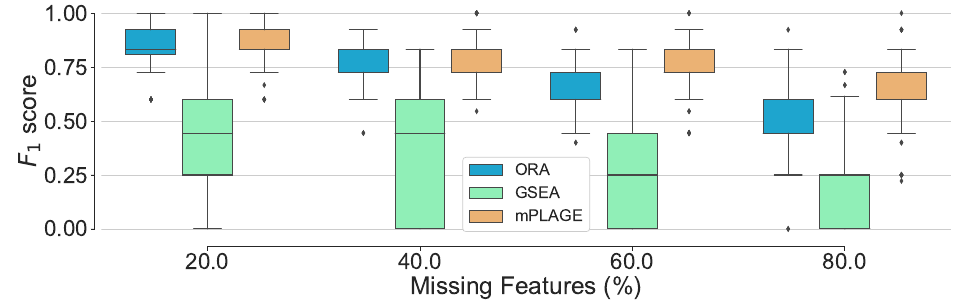
Figure 5. Overall performance of the different pathway ranking methods with missing features. Distribution of the F 1 scores for each method under an increasing proportion of missing features (20% to 80%) is shown. The results show that mPLAGE performs better, returning greater F 1 -scores at higher proportions of missing